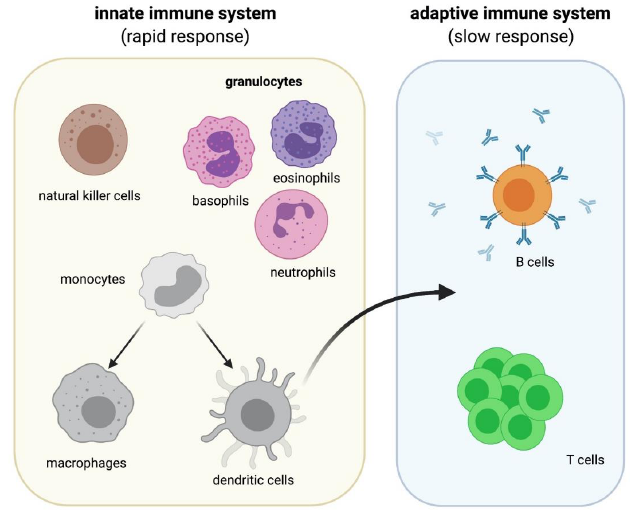
Figure 2. Overview of immune cells in the innate and adaptive immune systems. The schematic provides an overview of the two arms of the immune system: the innate immune system and the adaptive immune system. The innate immune system consists of granulocytes (basophils, neutro- phils, and eosinophils), natural killer cells, monocytes, macrophages, and dendritic cells. The adap- tive immune system consists of T cells and B cells with dendritic cells being the main bridge between the two systems. The innate immune system is the first line of defense against pathogens. It is made up of granulocytes, natural killer (NK) cells, monocytes, macrophages, and dendritic cells (DCs) (Figure 2). Neutrophils, basophils, and eosinophils are all considered granulocytes; neutrophils are the most abundant granulocyte in the immune system. They are an essen-